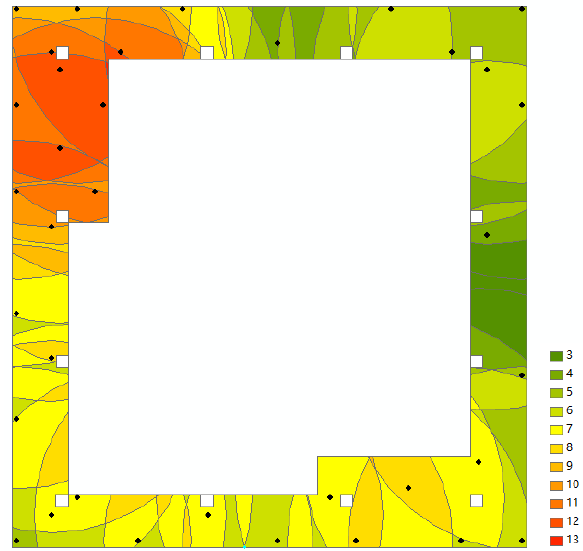
Figure 13. The result in experimental